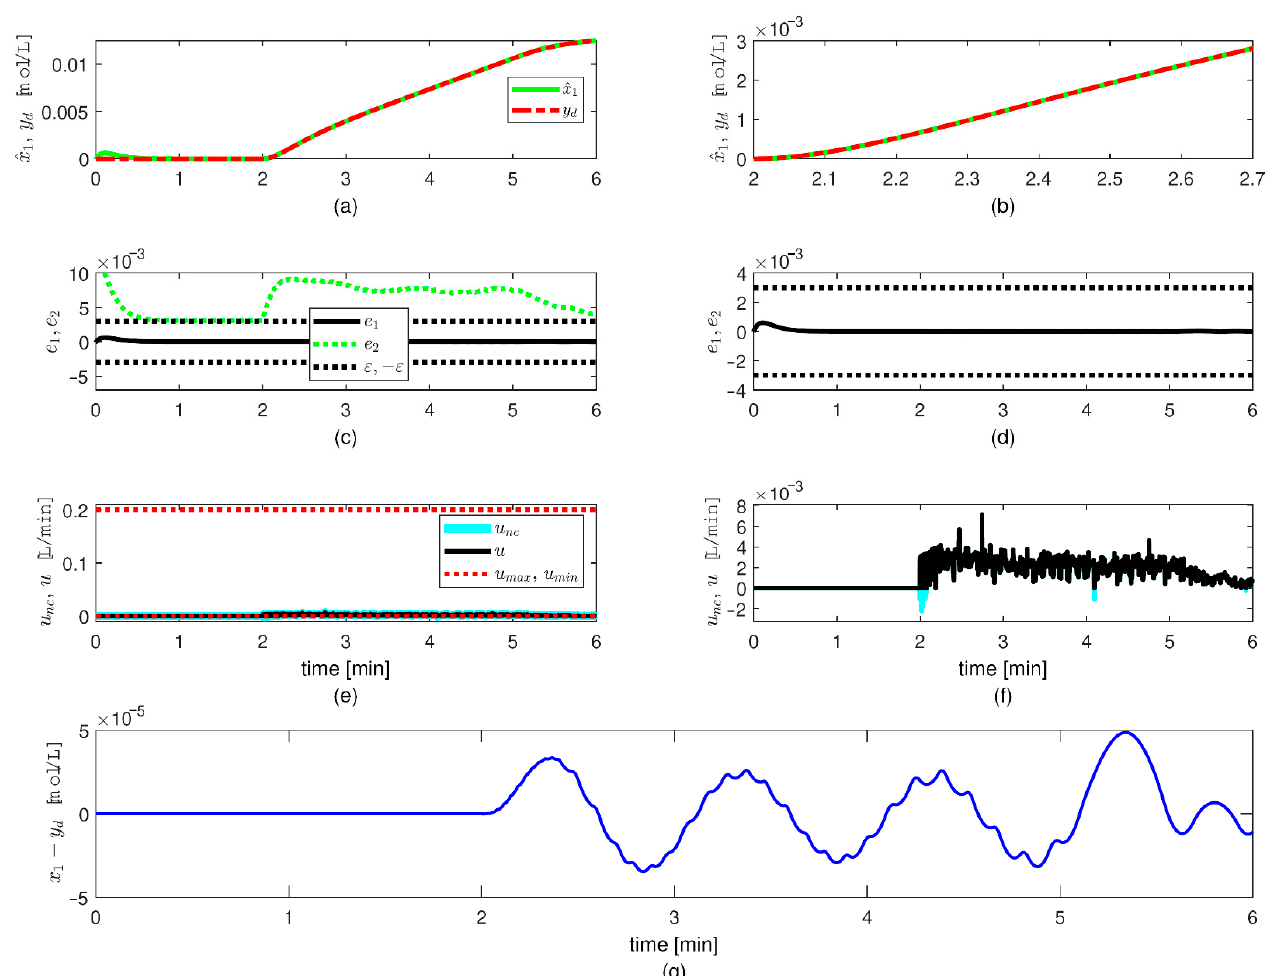
Figure 4. Controller simulations for the second case. ( a ) Time course of the estimated state ˆ x 1 and desired tracking trajectory y d . ( b ) Detail of time course of ˆ x 1 and y d . ( c ) Time course of the tracking error e 1 = ˆ x 1 − y d and e 2 = ˆ x 2 − x 2 d . ( d ) Detail of time course of e 1 , e 2 . ( e ) Time course of the unsaturated and saturated signals u nc , u . ( f ) Detail of time course of signals u nc , u . ( g ) Time course of x 1 − y d